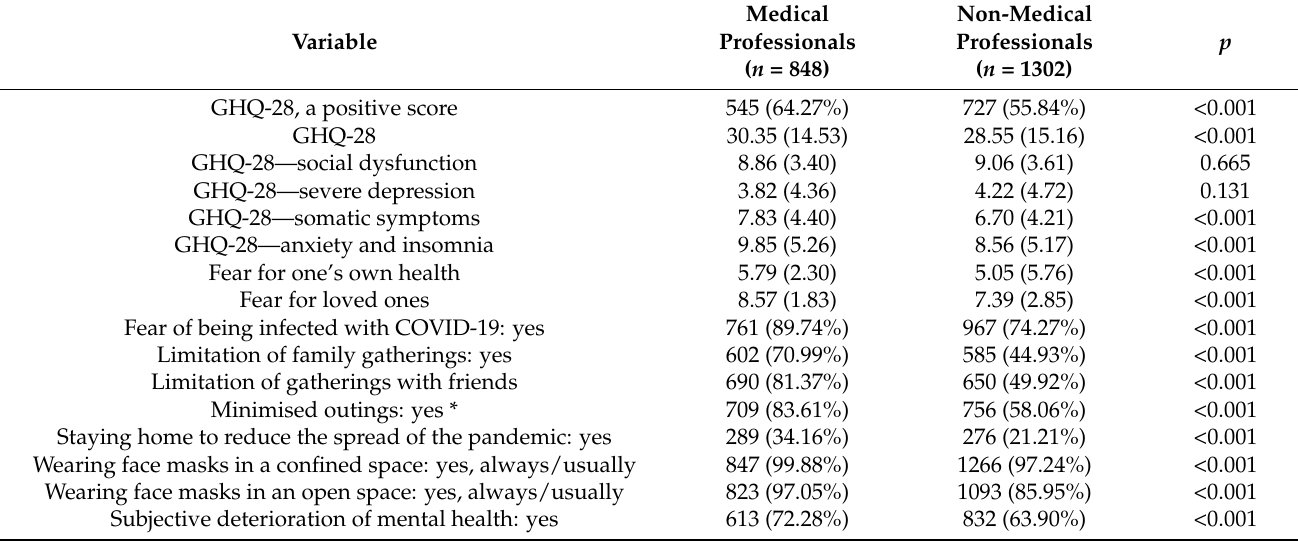
Table 2. The comparison of mental health according to medical/non-medical